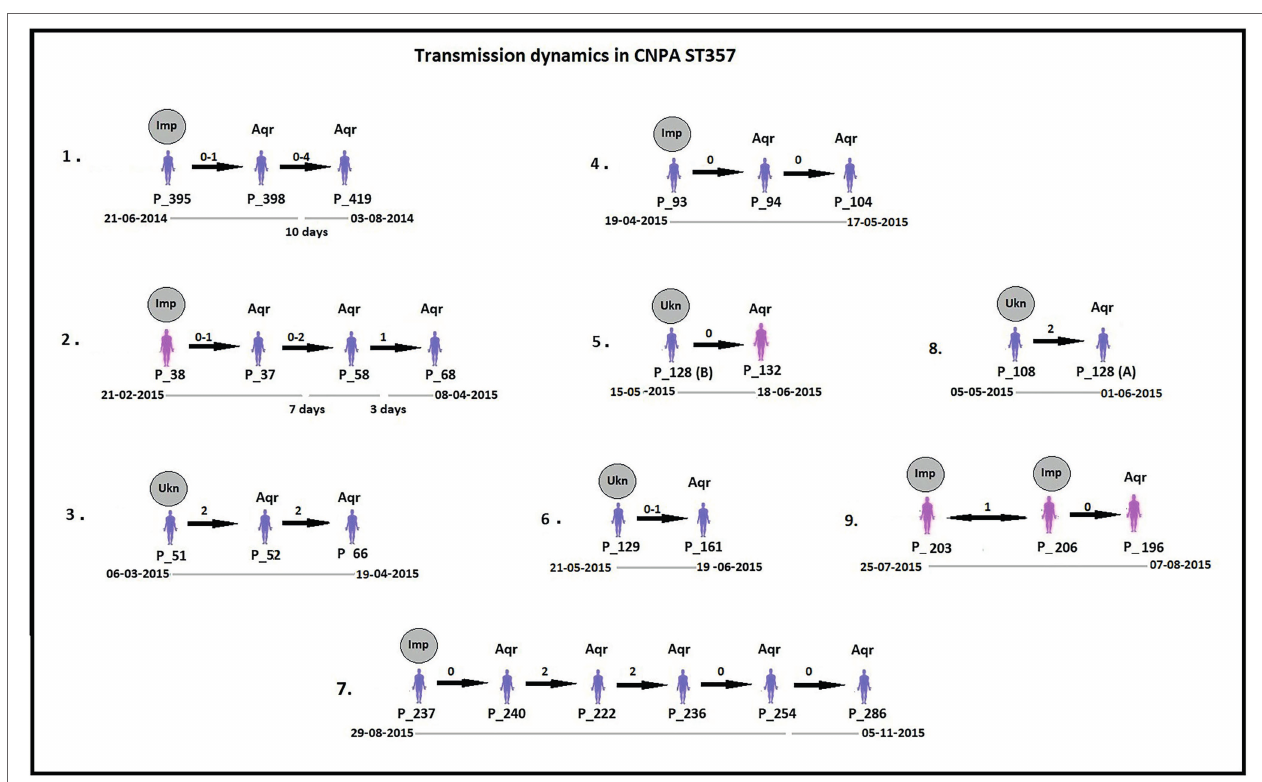
FIGURE 7 | Potential transmissions of CNPA ST357 isolates among the patients are shown. Pink colored patients (their ID given as “P_”) are from adult-ICU and purple colored patients are from ER-ICU. Strain relatedness in terms of pairwise wgSNP distances (0–4) among the strains is shown on the respective arrow between the two patients harboring strains associated with the transmission event. In some patients, more than one isolate was collected, therefore the pairwise wgSNP distances have a range between the two patients. All these transmissions are arranged in ascending order according to their time of admission to the ICU and their sample collection date from the year 2013 to 2015. The gray circle above first patient in each transmission event denotes that CNPA strain either imported (if labeled as “Imp”) from outside at the time admission or acquired from unknown (if labeled as “Ukn”) source within the ICU. Other patients in each transmission chain labeled “Aqr” which means they acquired these clones during hospitalization. Hospitalization time line of the patients is shown below each transmission chain. The gap in the time line depicts that there is a time difference between discharge of one patient and admission of another to the ICU. 6 th Transmission chain shows an unusual situation where two patients (203 and 206) possibly the part of a transmission event but both of them were already imported with ST235 strain. Therefore the probability of transmission could be to or from P_203 or P_206 during their overlapping days of stay in the